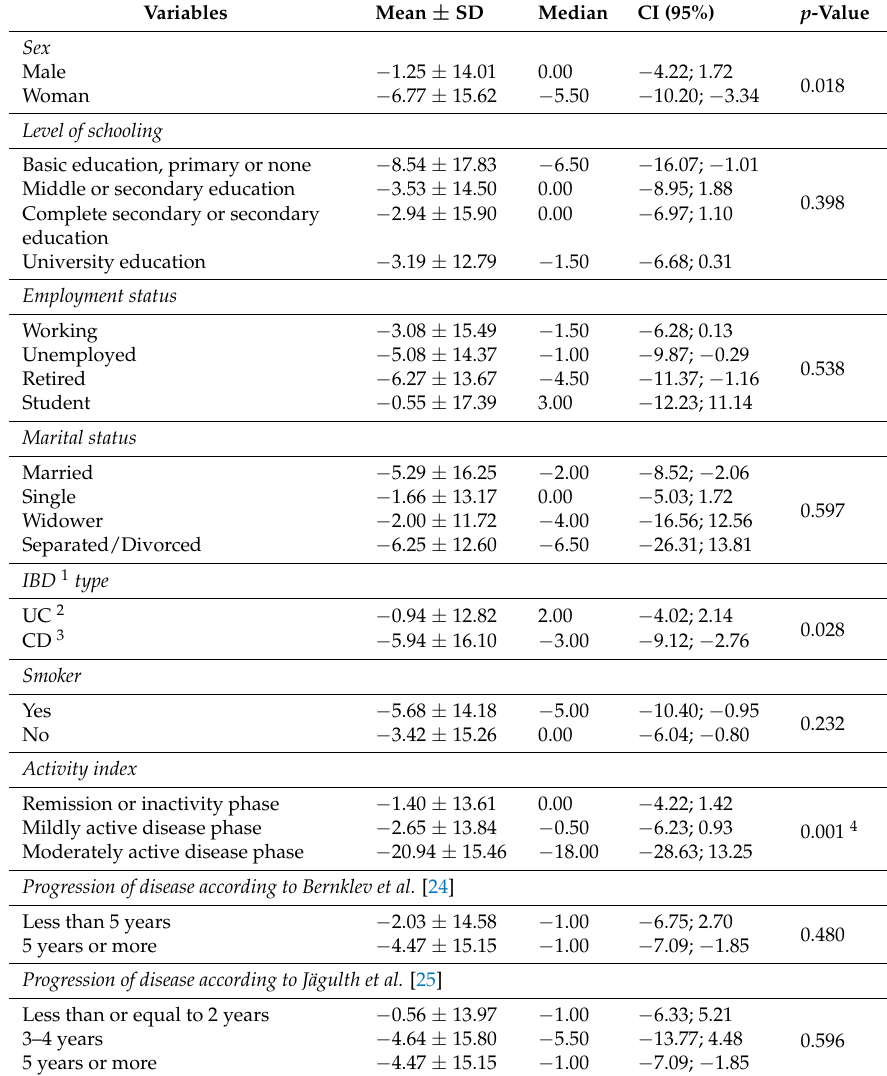
Table 3. Inflammatory Bowel Disease Disability Index contrast with sociodemographic and clinical (categorical)